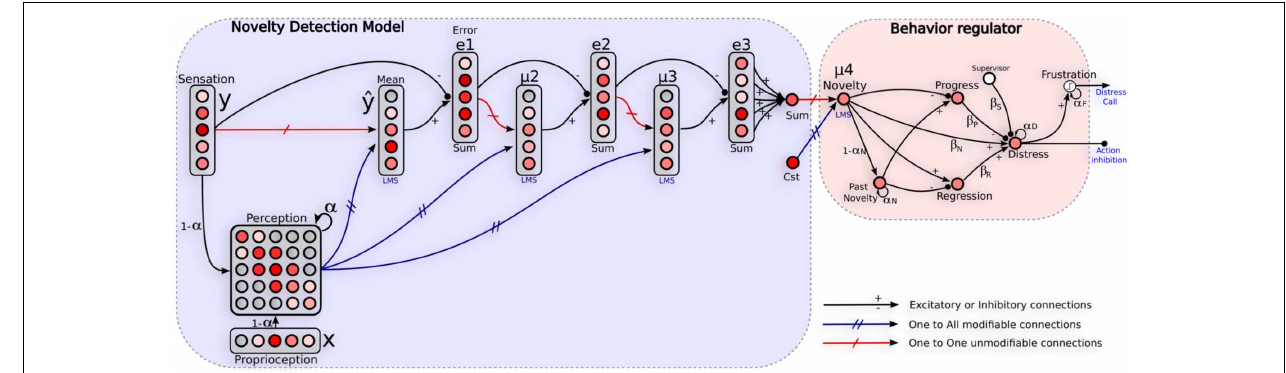
the behavior involved. Right: Emotional controller regulating the behavior. A recurrent neuron (Distress) integrates instant progress and regress of the prediction error, and novelty activity to take into account stagnation of such a prediction error. Actions proposed by the corresponding strategy are inhibited proportionally to the distress level. A neuron (Frustration) fires only when the distress activity reaches a threshold allowing the system to call for help. α x and β x represent weights of the regulator’s